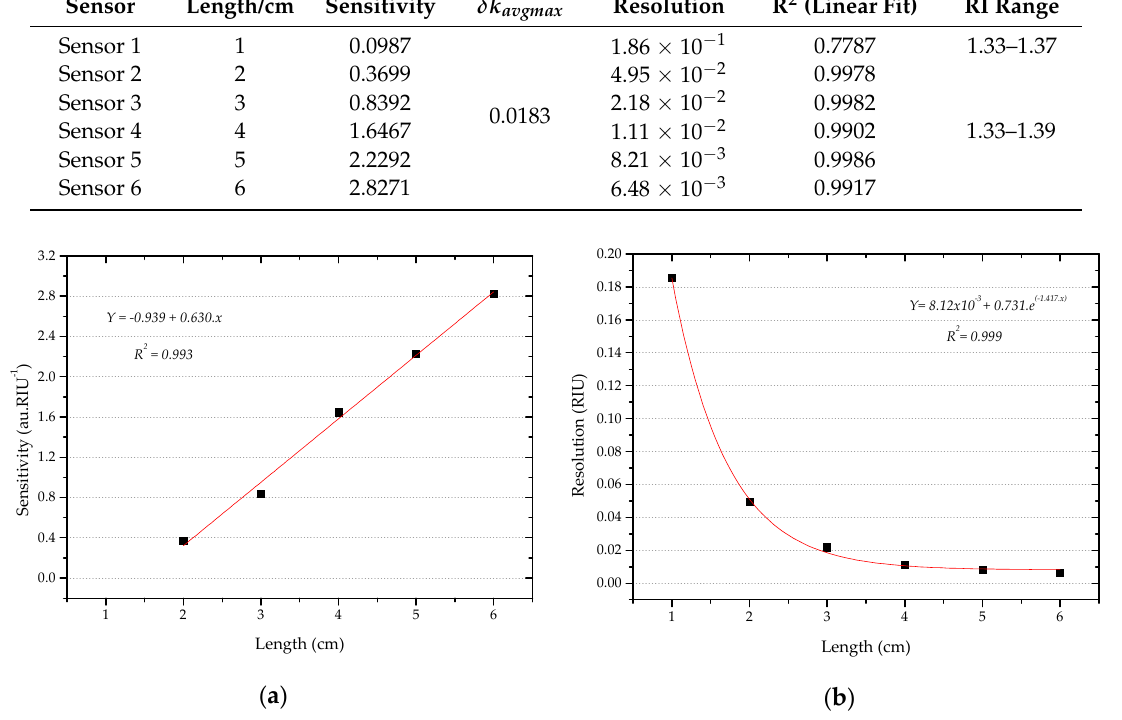
Figure 7. RI: 1.33–1.39: ( a ) Sensitivity and ( b ) resolution of the D-shaped sensors vs. length of the sensing region. For the D-shaped sensor with 1 cm length (Sensor 1), the resolution obtained is for the refractive index range 1.33–1.37 RIU. Table 1. RI: 1.33–1.39—Sensitivity and resolution of the D-shaped sensors, given by Equations (6) and (7).